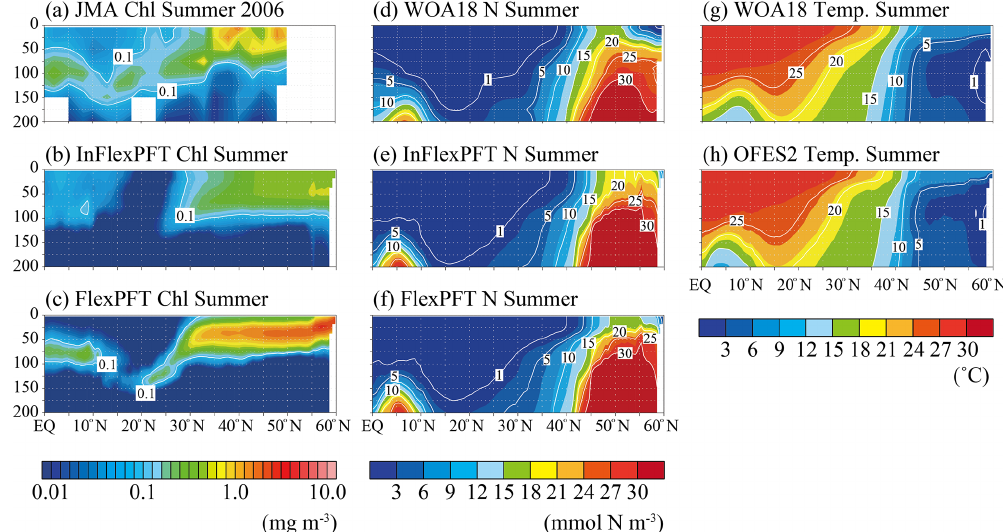
Figure 2. Comparison of the vertical distributions of (a) – (c) summer (June, July and August) Chl concentration (mgm − 3 ), (d) – (f) summer N concentration (mmolNm − 3 ), and (g) – (h) summer T ( ◦ C) along 165 ◦ E (north–south section; white circles in Fig. 1). Panel (a) shows in situ observation data from the summer of 2006 taken by the JMA research vessel. Panels (d) and (g) show data for the climatological summer from WOA18. Panels (b) , (c) , (e) , (f) , and (h) show the models’ average values for the summer during the 2000–2019 period. The white area in (a) represents missing